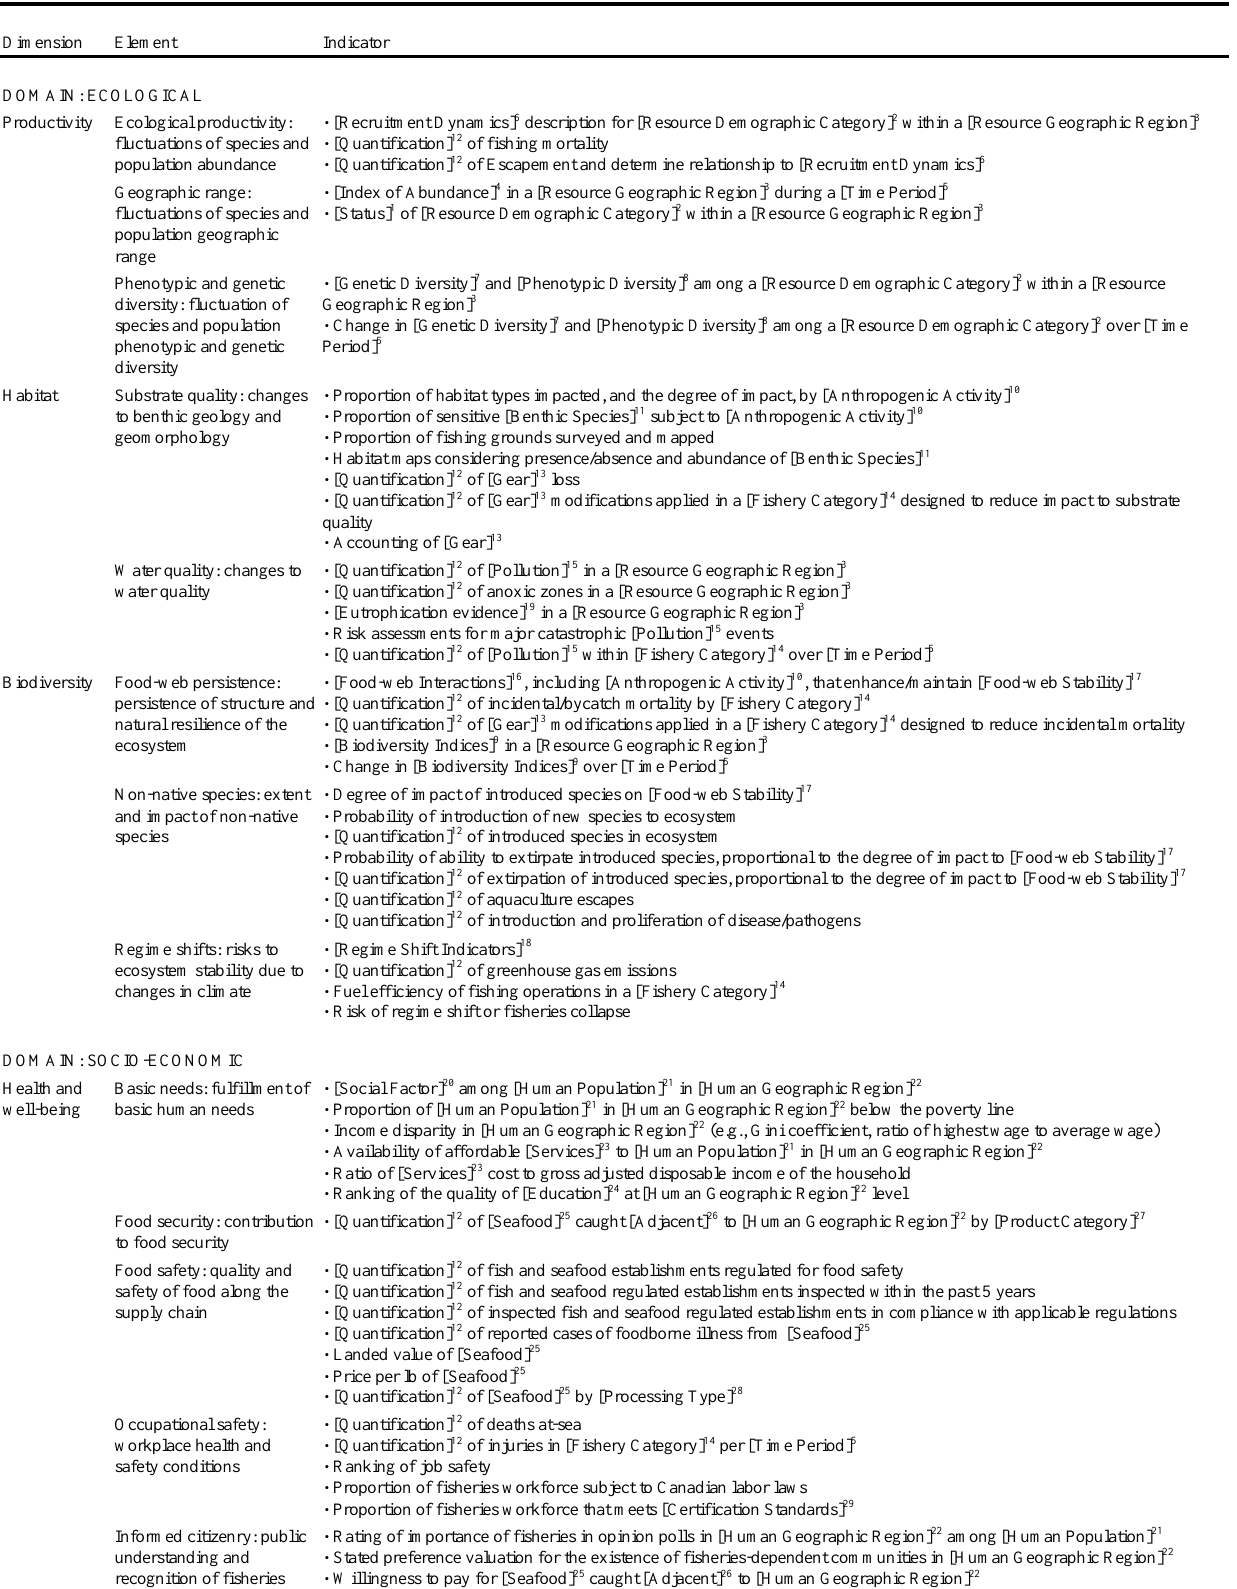
Table 1 . Canadian Fisheries Research Network Framework for Sustainable Fisheries, Version 2.1 with domains, dimensions, elements, indicators, and attributes. Dimension Element